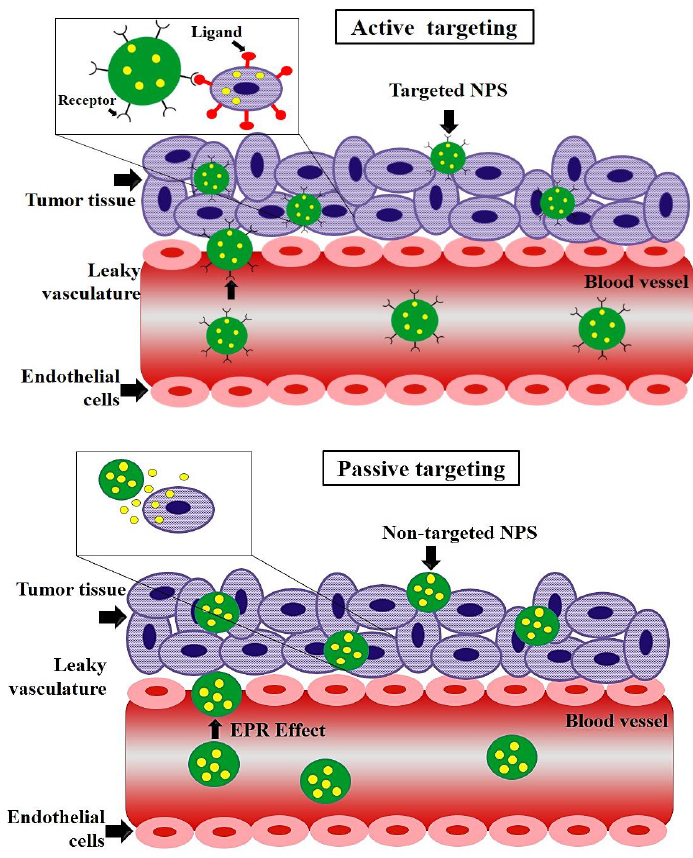
Fig. 1: Comparison of active and passive targeting